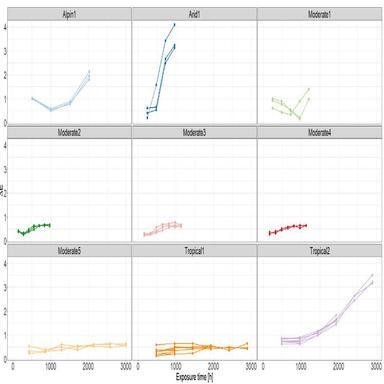
Change of colour parameter ΔE of the backsheets for the nine ageing actions.